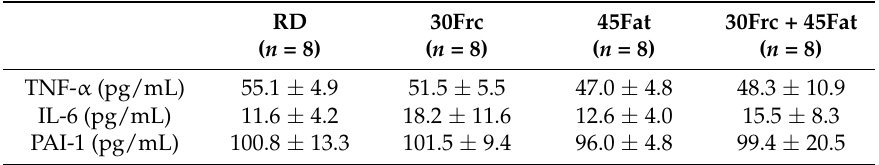
Table 5. Serum levels of pro-inflammatory cytokines.